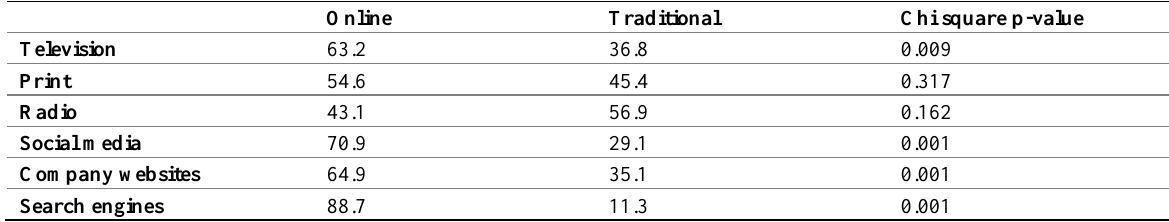
Table 5: Media use